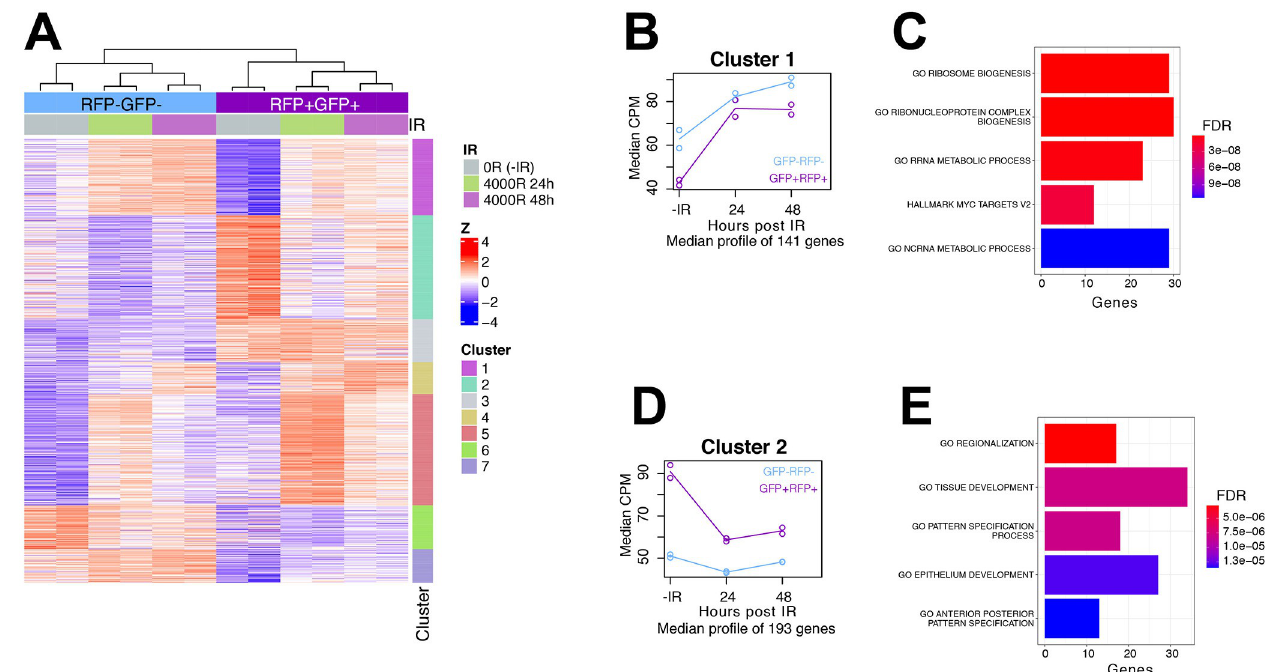
Fig 3. Time series and ORA analysis. (A) Heatmap of 821 significant genes from the time series analysis. Expression data is in S1 Table. Gene names are in S2 Table. (B) Median expression (counts per million) of the genes in Cluster 1 at various treatment and time points. Gene names are in S3 Table. Pairs of circles represent data from two biological replicates. (C) Top five most significant gene sets following ORA for genes in Cluster 1 are shown with FDR- adjusted p-values. Gene names are in S3 Table. (D) Median expression (counts per million) of the genes in Cluster 2 at various treatment and time points. Pairs of circles represent data from two biological replicates. (E) Top five most significant gene sets following ORA for genes in Cluster 2 are shown with FDR-adjusted p-values. Gene names are in S3 Table.